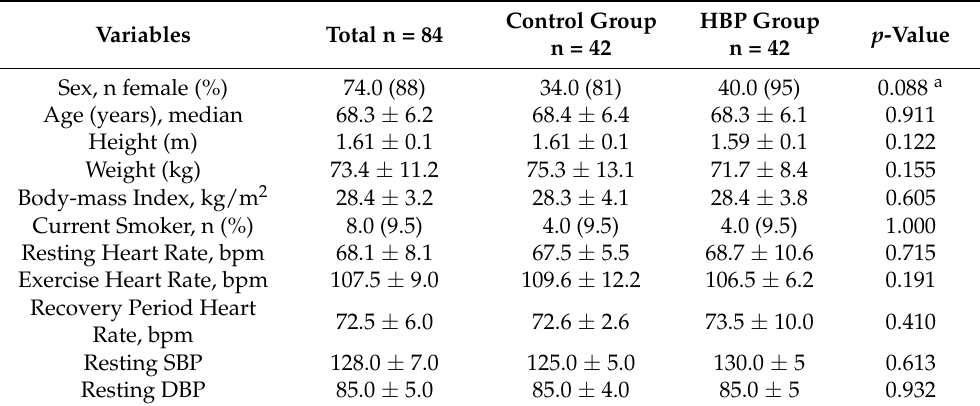
Table 1. Baseline characteristics of participants according to sex, age, height, weight, body mass index, smoking, blood pressure, and heart